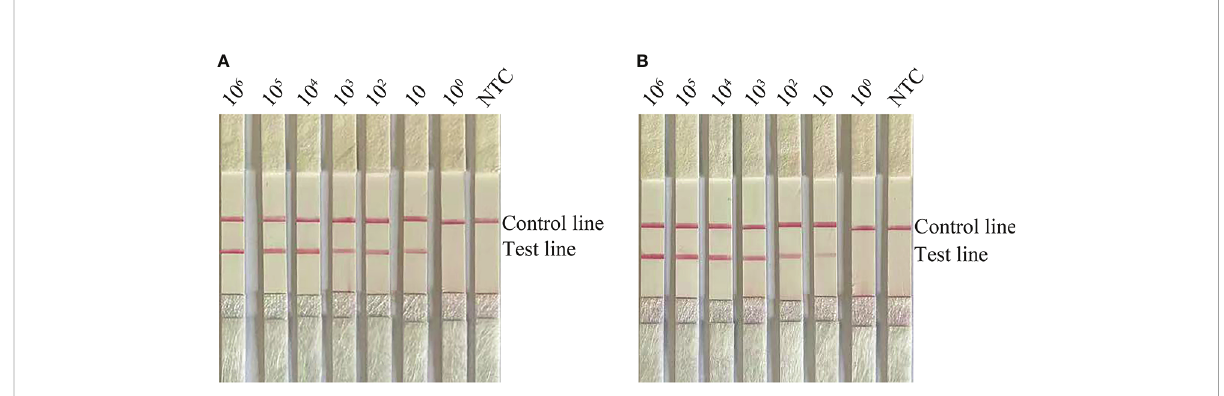
FIGURE 2 Determination of the LOD of C glabrata RPA-LFS. (A) The LOD of the C glabrata RPA-LFS assay system was established by using primer – probe set F4/R2/P using genomic DNA of C glabrata and serial dilutions of 10 0 to 10 6 CFU for each reaction. The picture shows the results of RPA-LFS with the number of templates shown at the top of the bar graph. (B) The picture shows the results of the RPA-LFS assay using primer – probe set F4/R2/P and 10 5 CFU of C albicans as interference.